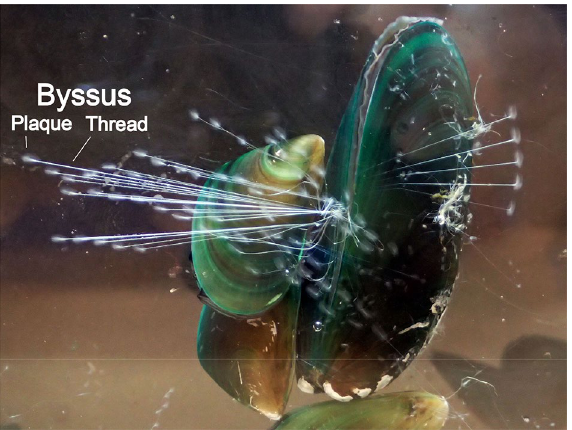
Figure 1. Green mussels, Perna viridis , attached to a transparent acrylic board, using the byssus, consisting of threads and plaques.